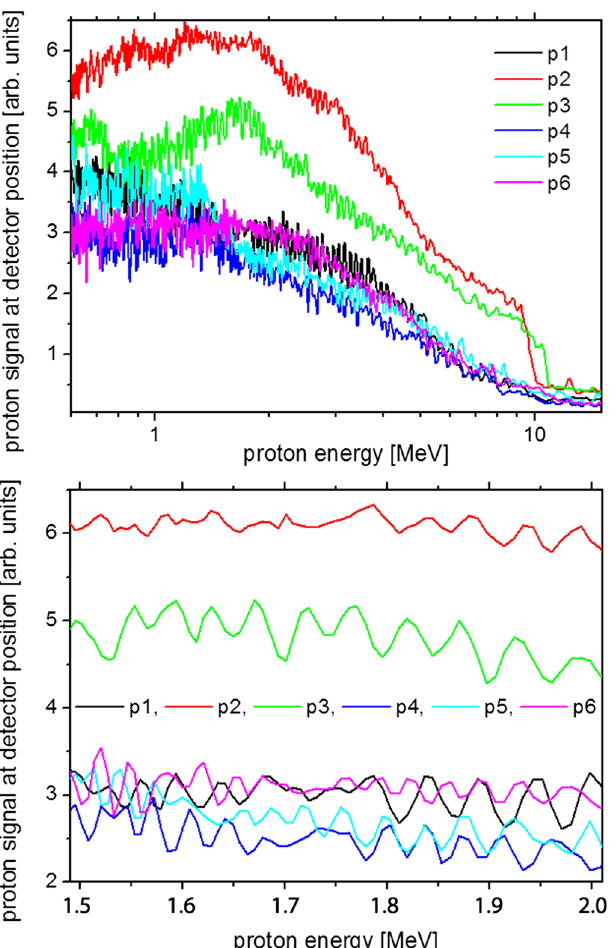
FIG. 2. Fast protons produced with 7 × 10 19 W = cm 2 laser- irradiated 5 μ m Ti foils (the lower graphic shows parts of the traces with an enlarged energy interval similar to insets in Fig. 1): linear polarization applied for p 1 (black), p 5 (cyan), and p 6 (purple) and circular polarization applied for p 2 (red), p 3 (green), and p 4 (blue); spectrometer slit widths were 340 μ m for p 1 and p 2 , 240 μ m for p 3 , and 50 μ m for p 4 – p 6